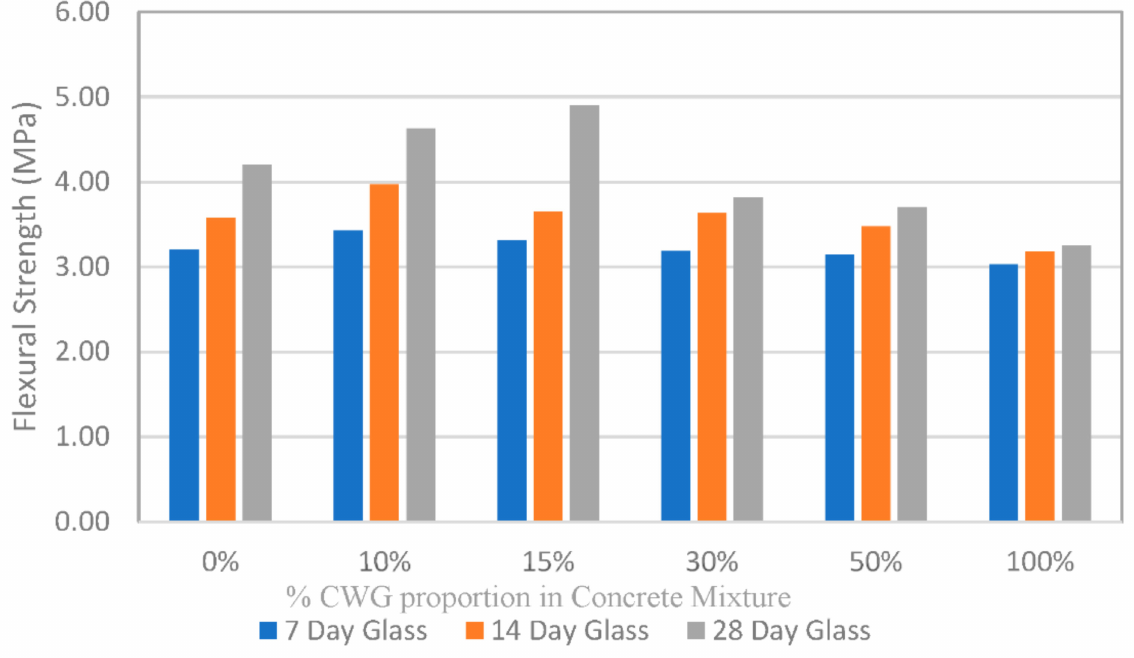
Figure 15. Trends in the flexural strength of concrete samples with percentage of